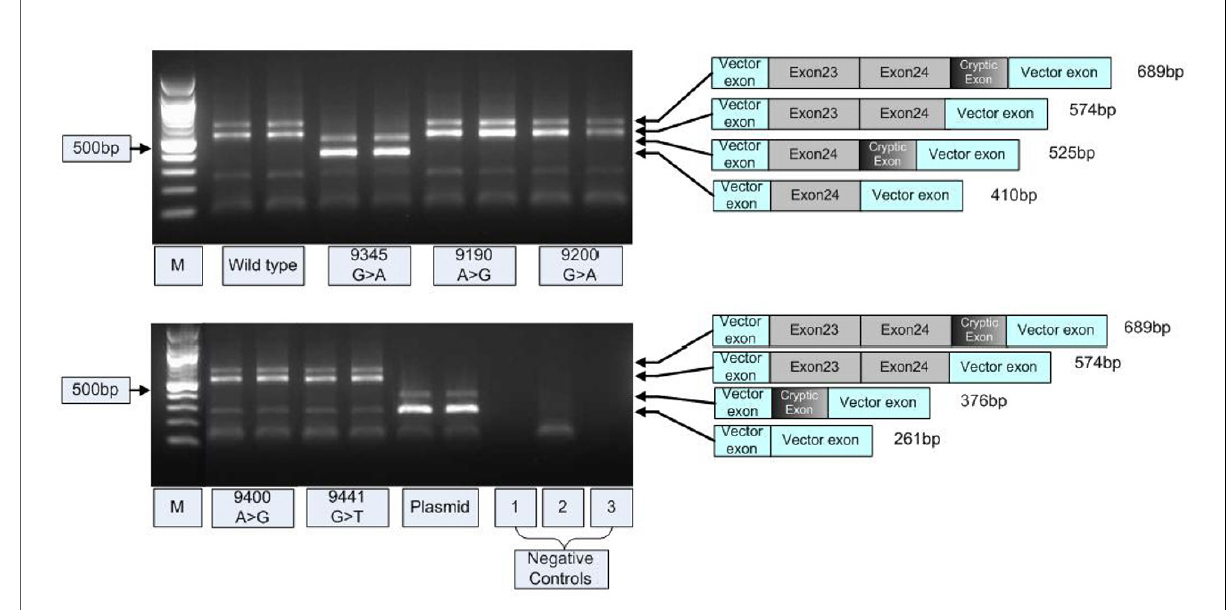
Figure 2 No evidence for altered splicing of transcripts derived from minigenes incorporating the BRCA2 unclassified variants: c.8962A > G (p.Ser2988Gly), c.8972G > A (p.Arg2991His), c.9172A > G (p.Ser3058Gly), and c.9213G > T (p.Glu3071Asp) . RT-PCR products from duplicate cell culture experiments for each minigene construct and a vector only control. The vector only sample does not contain an insert and therefore pro- duces a 261 bp band made up of fragments of pSPL3 constitutive exons. The positive control, BRCA2 c.9117G > A (p.Pro3039Pro) produces a 410 bp band representing the vector exons and BRCA2 exon 24. The higher molecular weight band in all samples includes a 115 bp cryptic exon. The 574 bp band seen in all unclassified variants and the wildtype represents the vector exons and BRCA2 exons 23 and 24. Negative controls include: 1. No reverse transcriptase in cDNA synthesis of the wild type construct; 2. No template for the PCR; 3. Negative control for transfection. Fragments resolved 1.5% agarose gel stained with ethidium